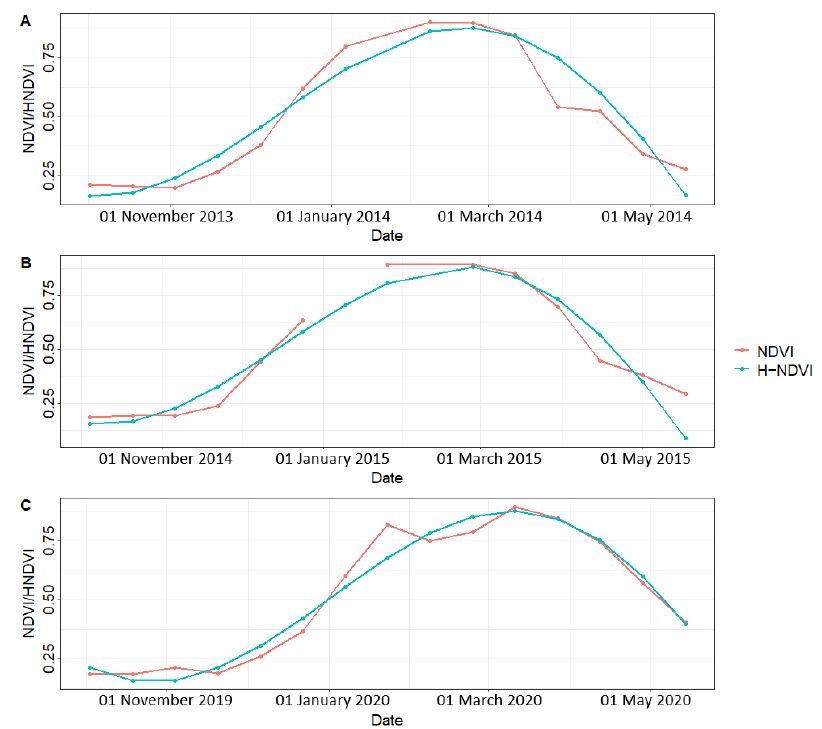
Figure 5. Mean NDVI and the transformed NDVI (H-NDVI) of the study area for the three time periods. ( A ) Original and H-NDVI time series for 2013/2014 season. ( B ) Original and H-NDVI time series for 2014/2015 season. ( C ) Original and H-NDVI time series for 2019/2020 season. Remote Sens. 2020 , 12 , x FOR PEER REVIEW